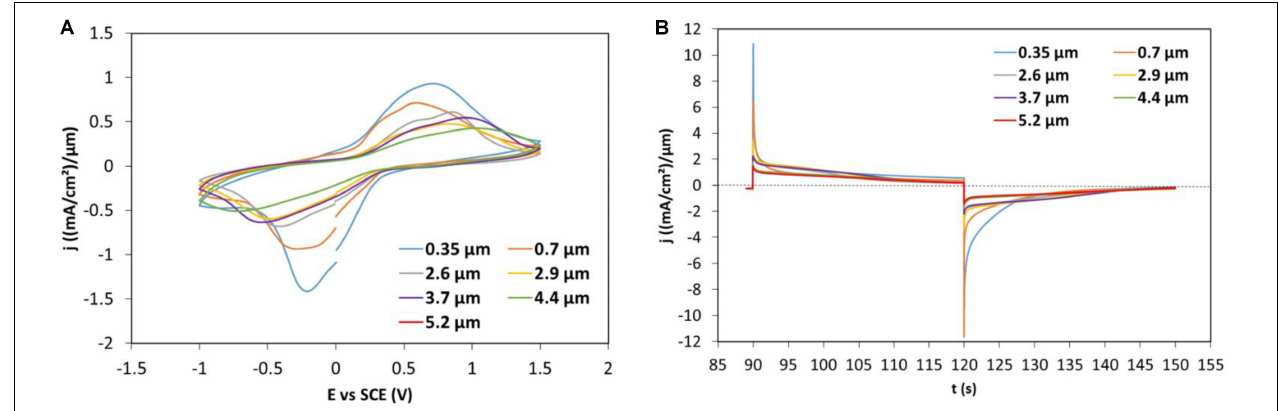
FIGURE 8 | (A) CVs of 90 wt%–10 wt% PEDOT:PSS-V 2 O 5 with various thicknesses cycled in PEDOT:PSS -V 2 O 5 /Li-electrolyte/Pt vs. SCE using a 20 mV/s scan rate varying between +1.5 V and –1 V (B) Corresponding CAs of the second cycle with E = +1.5 V for 30 s and E = –1 V for 30 s.